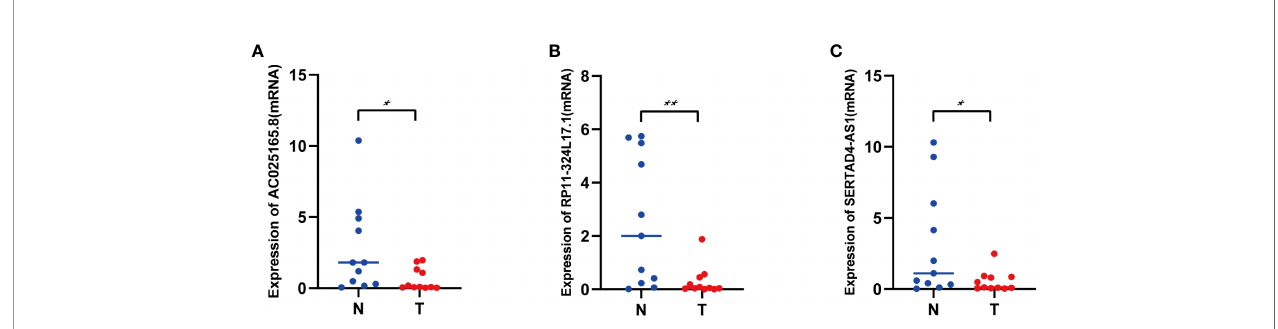
FIGURE 10 | The expression levels of three lncRNAs in COAD tissues and adjacent normal tissues. (A) The expression levels of AC025165.8 in carcinoma tissues and adjacent tissues. (B) The expression levels of RP11-324L17.1 in carcinoma tissues and adjacent tissues. (C) The expression levels of SERTAD4-AS1 in carcinoma tissues and adjacent tissues. (* p < 0.05; ** p